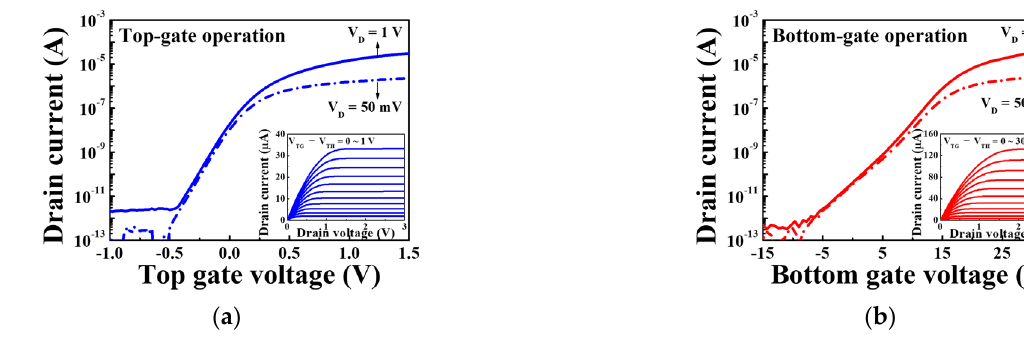
Figure 5. Transfer characteristic curves for the SiNW channel DG FETs operated by the ( a ) top gate and ( b ) bottom gate. The insets display the output characteristic curves.